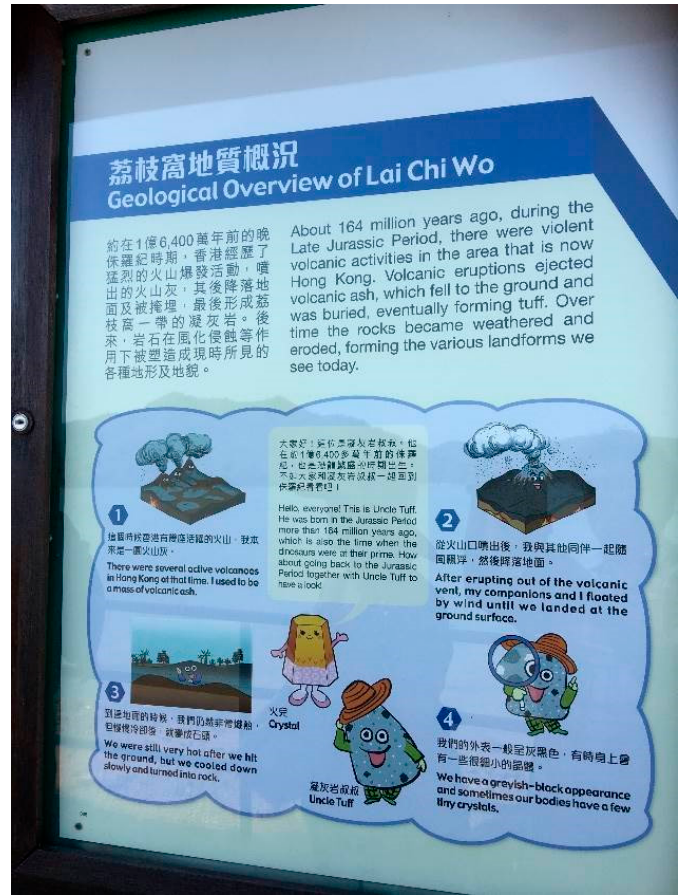
Figure 15. Geofolks on a Hong Kong UGGp panel in Lai Chi Wo.